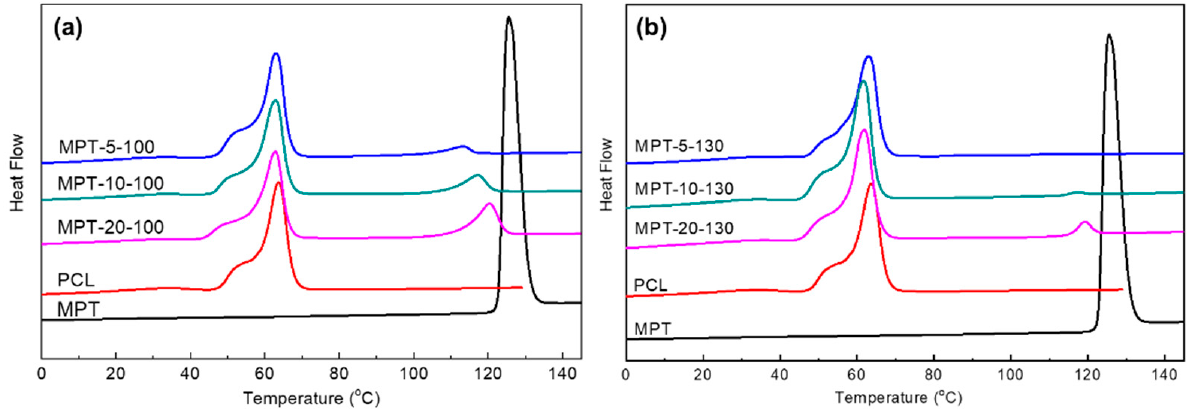
Figure A2. DSC heating curves of PCL/MPT blends with different processing temperatures: ( a ) 100 °C and ( b ) 130 °C.